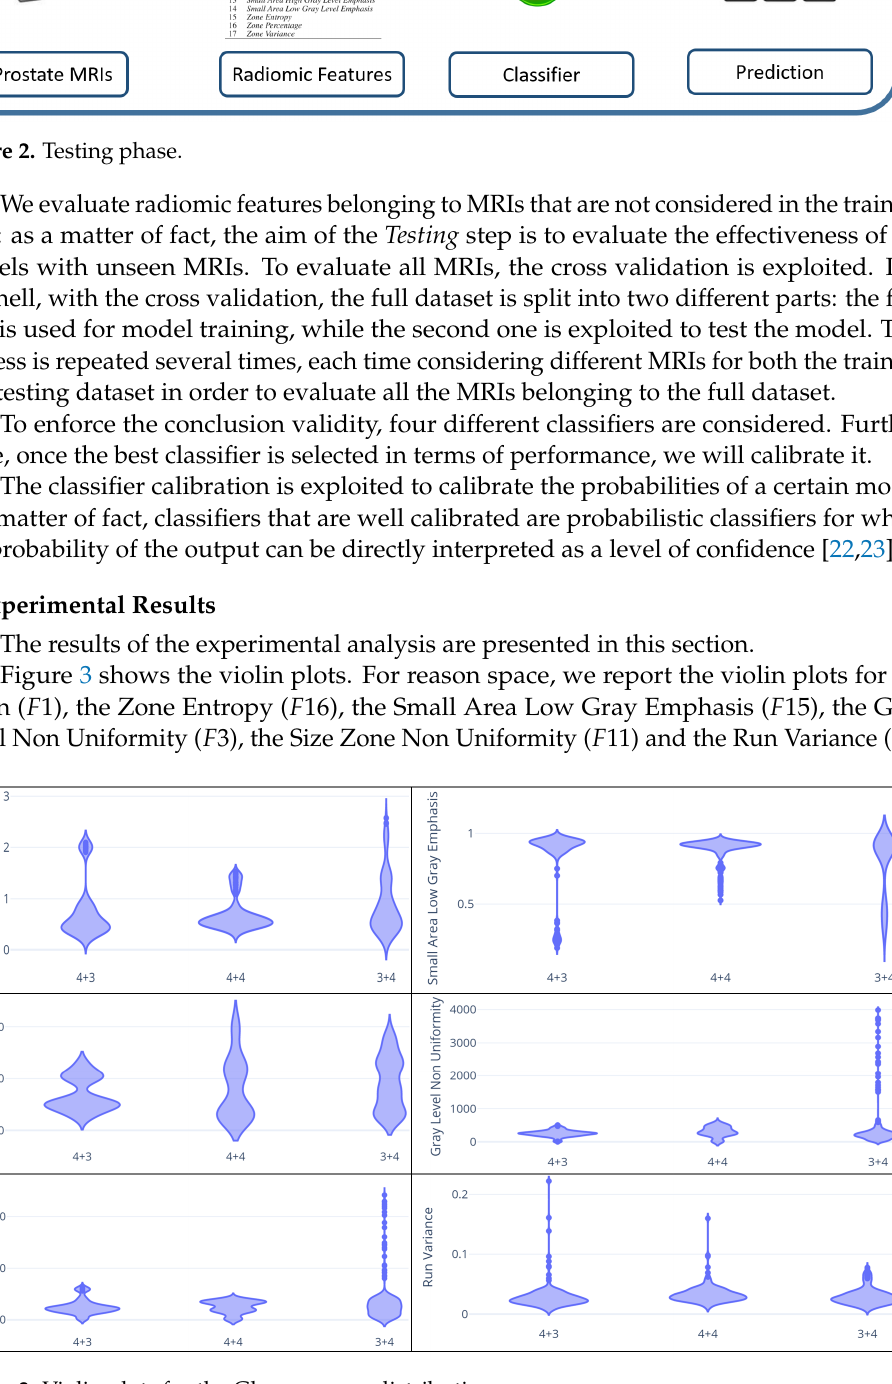
Figure 3. Violin plots for the Gleason score